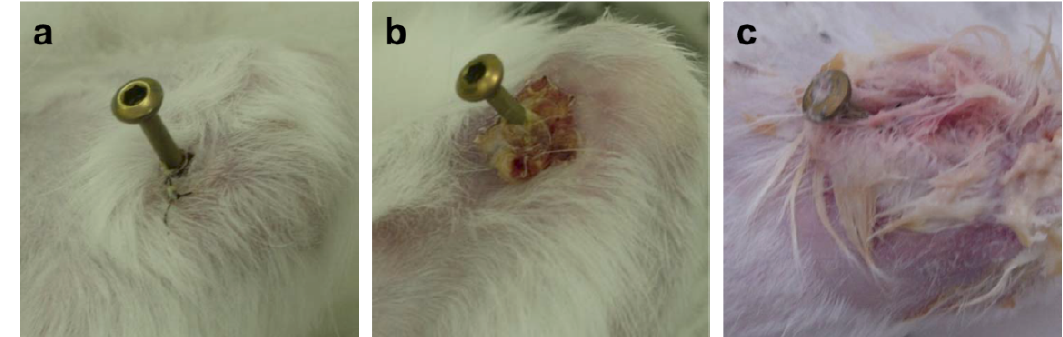
Figure 6. Typical appearances of pin tract infections 4 weeks after the operation. ( a ) Grade